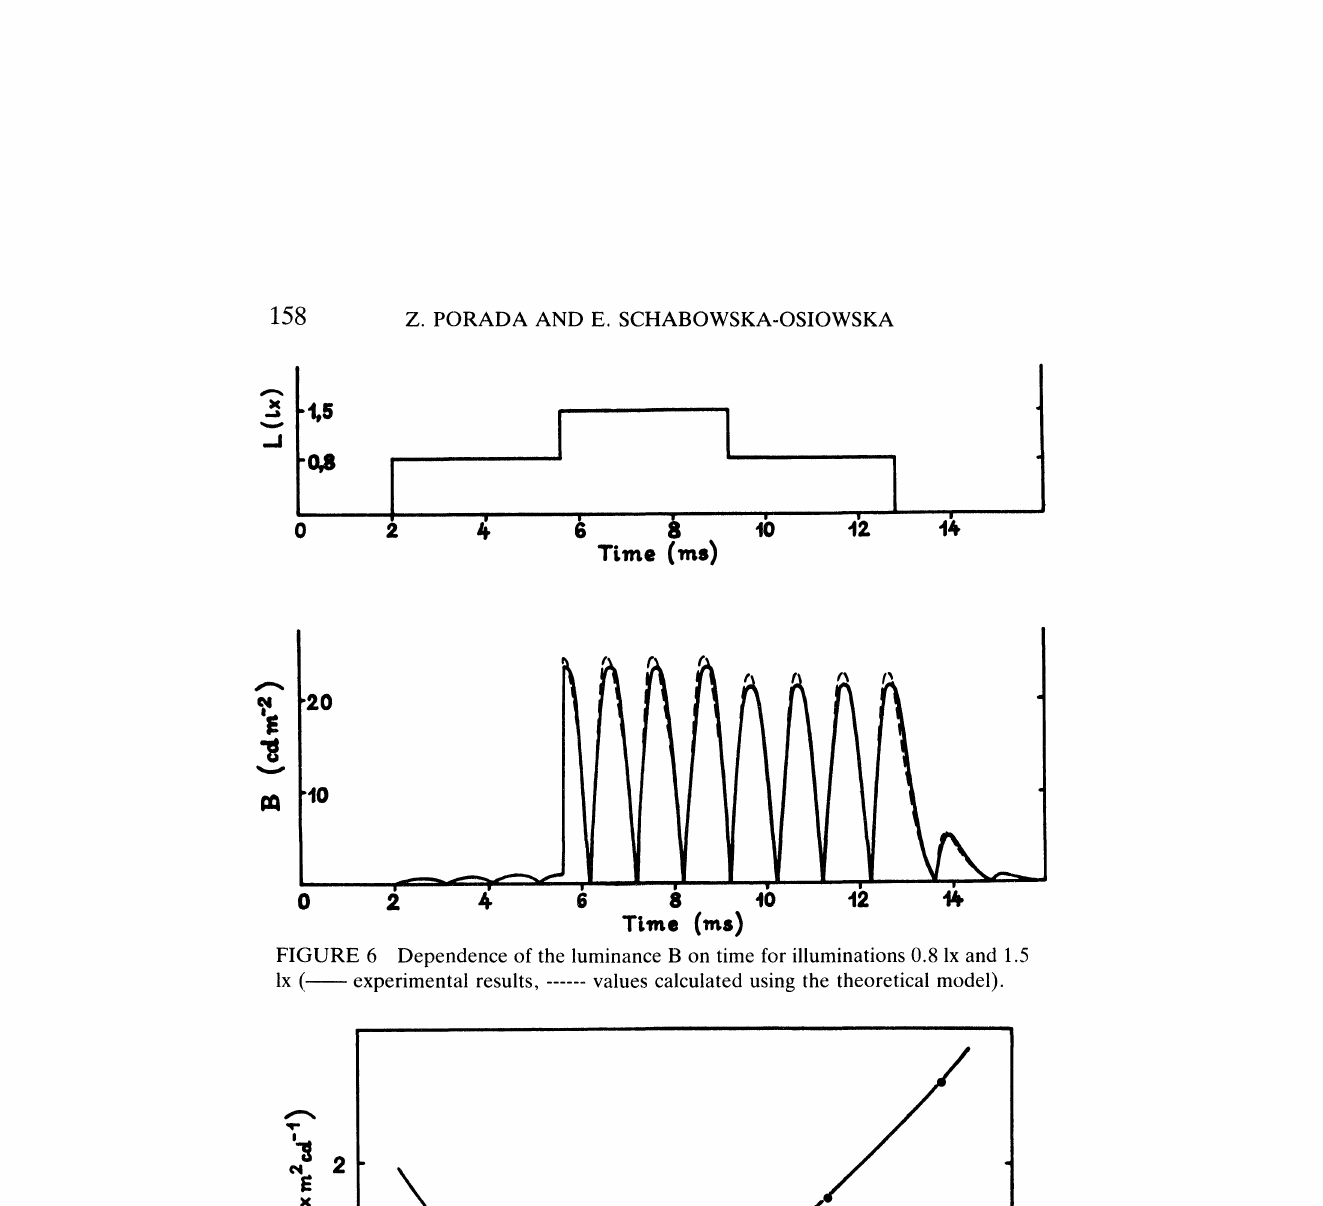
FIGURE 6 Dependence of the luminance B on time for illuminations 0.8 Ix and 1.5 Ix ( experimental results, values calculated using the theoretical model).